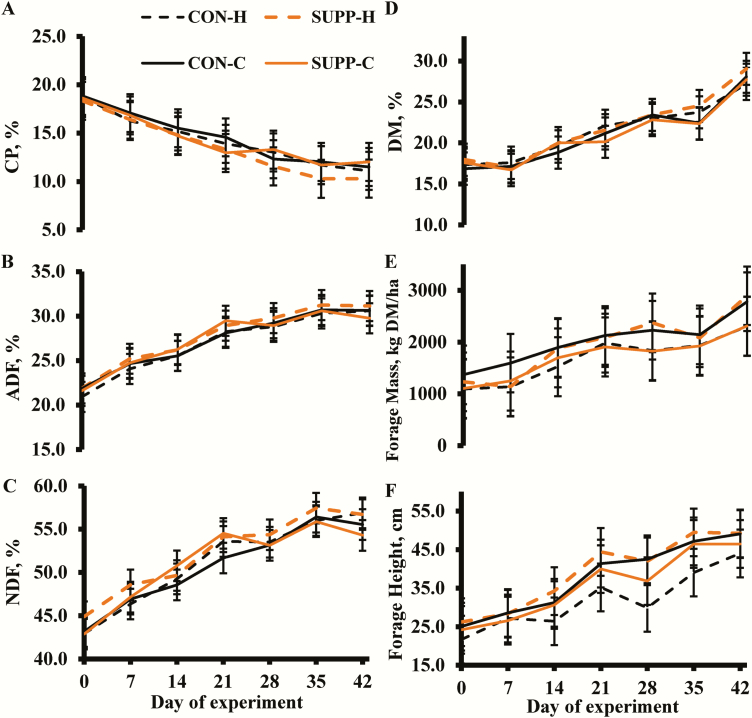
Pasture forage analysis (CP, ADF, NDF, DM, forage mass, and forage height) of the four treatment combinations (n = 8 groups per treatment combination): yearling heifers receiving no supplement (CON-H); yearling heifers receiving supplement of dry-rolled corn (SUPP-H; 1.81 kg as-fed/heifer/d) for 42 d; 2-yr-old lactating cow-calf pairs receiving no supplement (CON-C); and 2-yr-old lactating cow-calf pairs receiving supplement of dry-rolled corn (SUPP-C; 1.81 kg as-fed/cow/d) for 42 d from the end of April through early June in 2017 and 2018. Supplementation × age × time, supplementation × age, supplementation × time, age × time, supplementation, and age effects were not detected (P ≥ 0.28) for CP, ADF, NDF, or DM. Supplementation × age × time, supplementation × time, age × time, supplementation, and age effects were not detected (P ≥ 0.31) for forage height or forage mass. However, a supplementation × age effect was detected (P < 0.01) for forage mass and a trend (P = 0.08) was detected for forage height. There was a significant time effect (P < 0.01) on all forage classification parameters. Error bars = SEM.